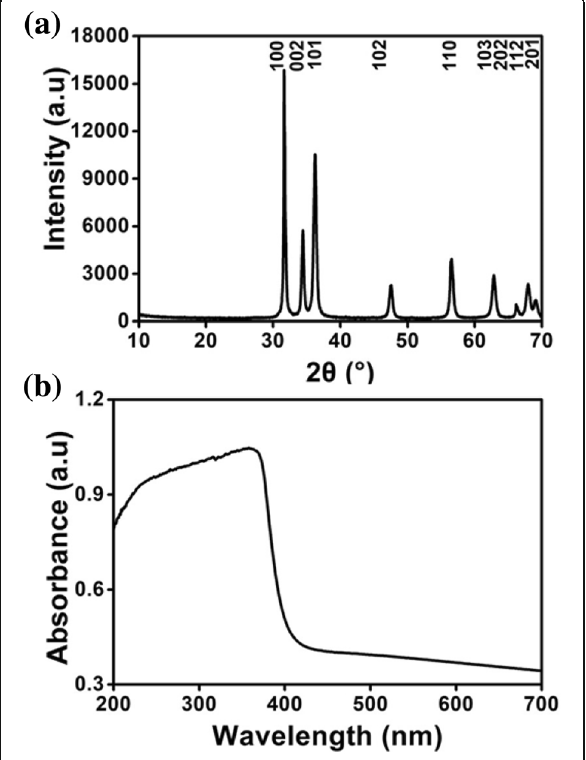
Fig. 5 XRD pattern ( a ) and UV-vis absorption spectrum ( b ) of ZnO